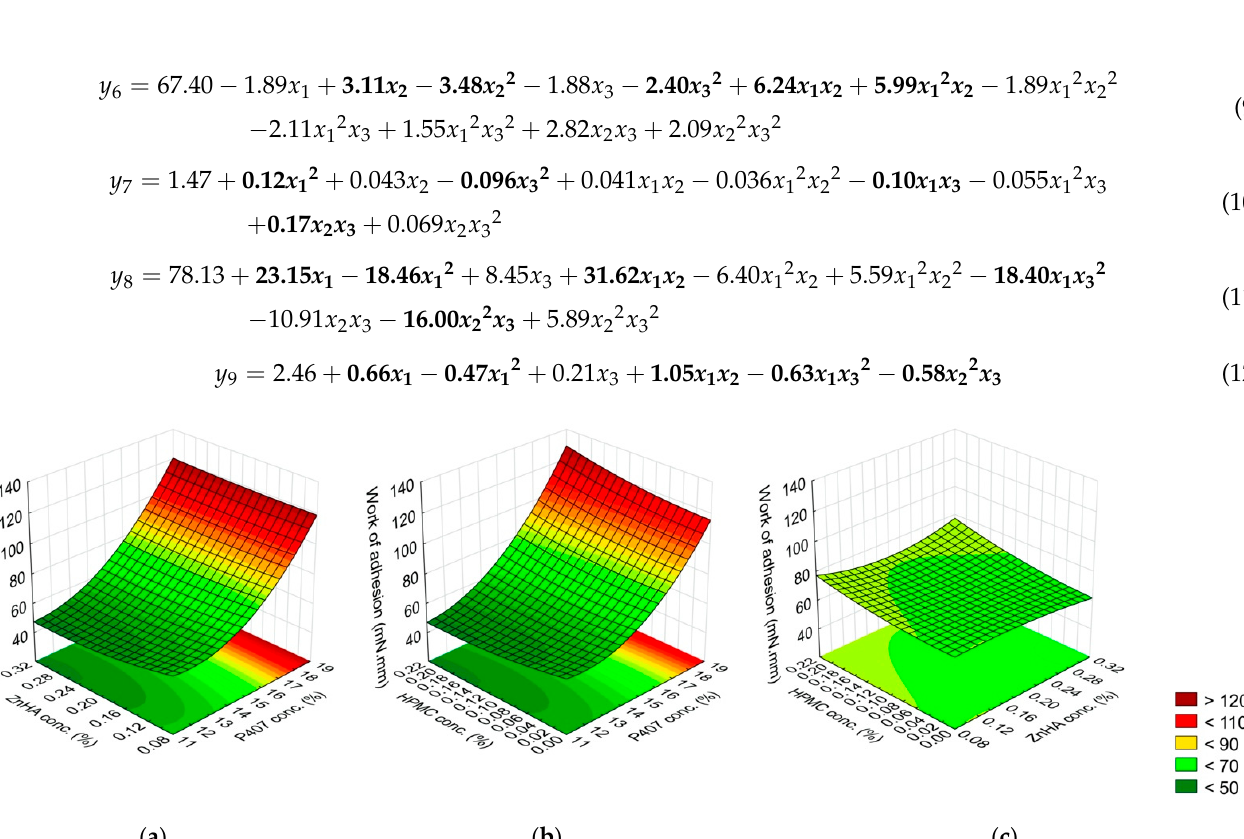
Figure 4. Effect of the composition on the adhesive force: ( a ) P407 and ZnHA concentrations, ( b ) P407 and HPMC concentrations, ( c ) ZnHA and HPMC; (the 3rd factor is at 0 level in each case).